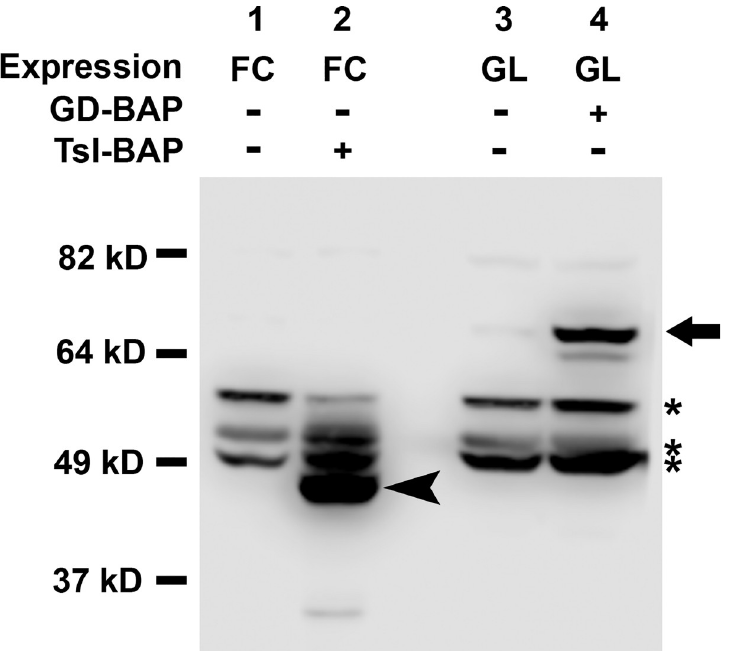
Fig 6. Biotin acceptor tags can be detected at the carboxy termini of Tsl-BAP and GD-BAP. Protein homogenates were prepared from ovaries from females expressing Tsl-BAP (+) in the follicle cells (FC) under the control of the CY2-Gal4 driver or from females expressing GD-BAP (+) in the germline (GL) under the control of the Nanos-Gal4 :: VP16 driver . Control homogenates (-) were from ovaries carrying only the corresponding Gal4 driver. Homogenates were subjected to Western blot analysis using an antibody directed against BAP tag. The antibody recognizes both Tsl- BAP (arrowhead) and GD-BAP (arrow). Endogenous background bands are also indicated ( � ).